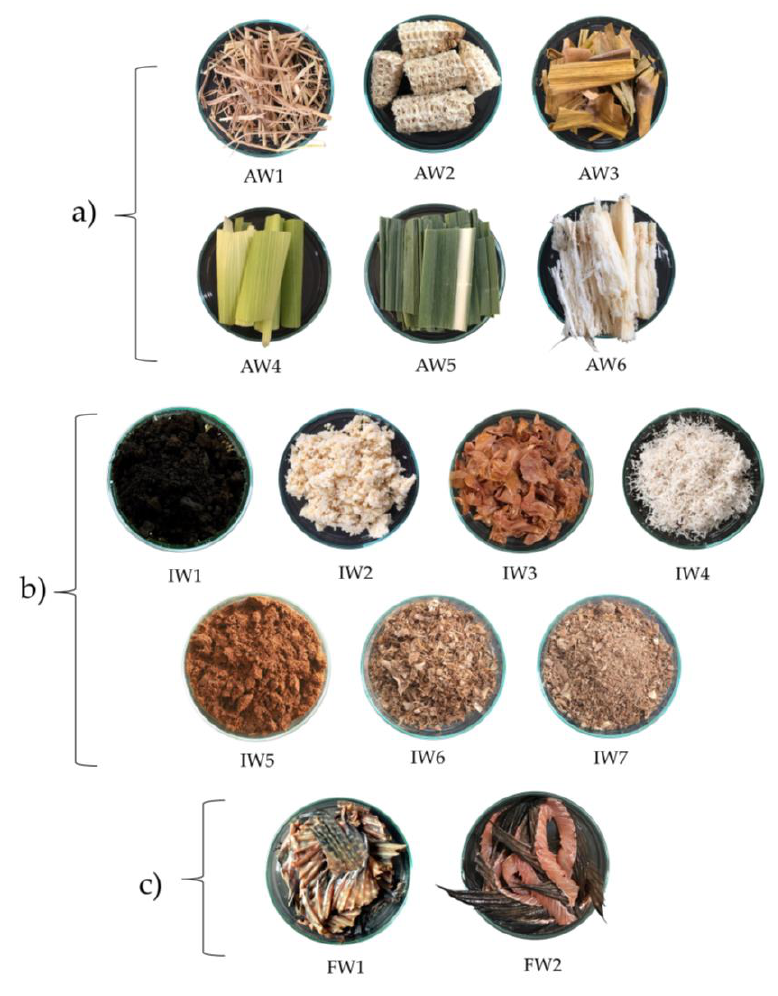
Figure 4. The three groups of waste samples: ( a ) agricultural wastes (AW), ( b ) agro-industrial wastes (IW), and ( c ) fishery wastes